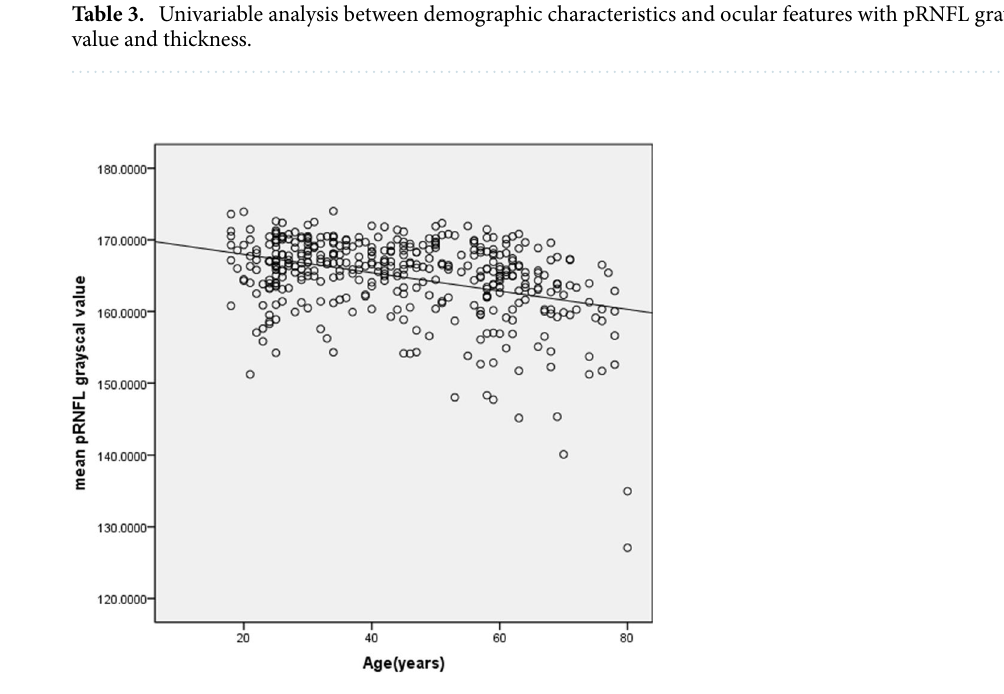
Figure 3. Scatterplot of mean pRNFL grayscale value against the age of study subjects